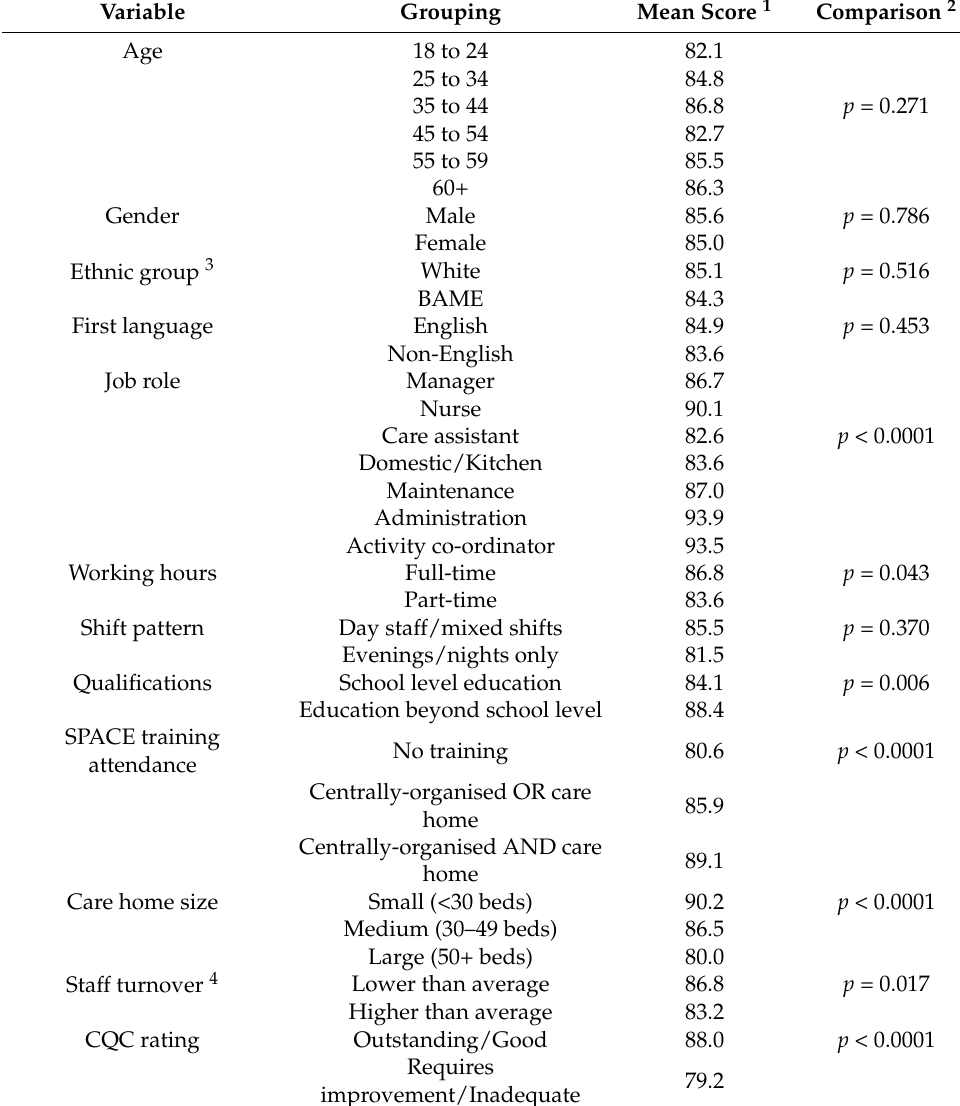
Table 3. Sub-group analysis of mean SAQ safety climate scores at 24